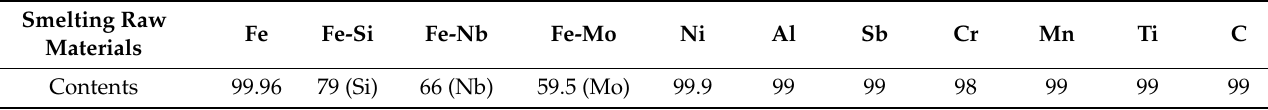
Table 1. Content of main elements in various smelting raw materials